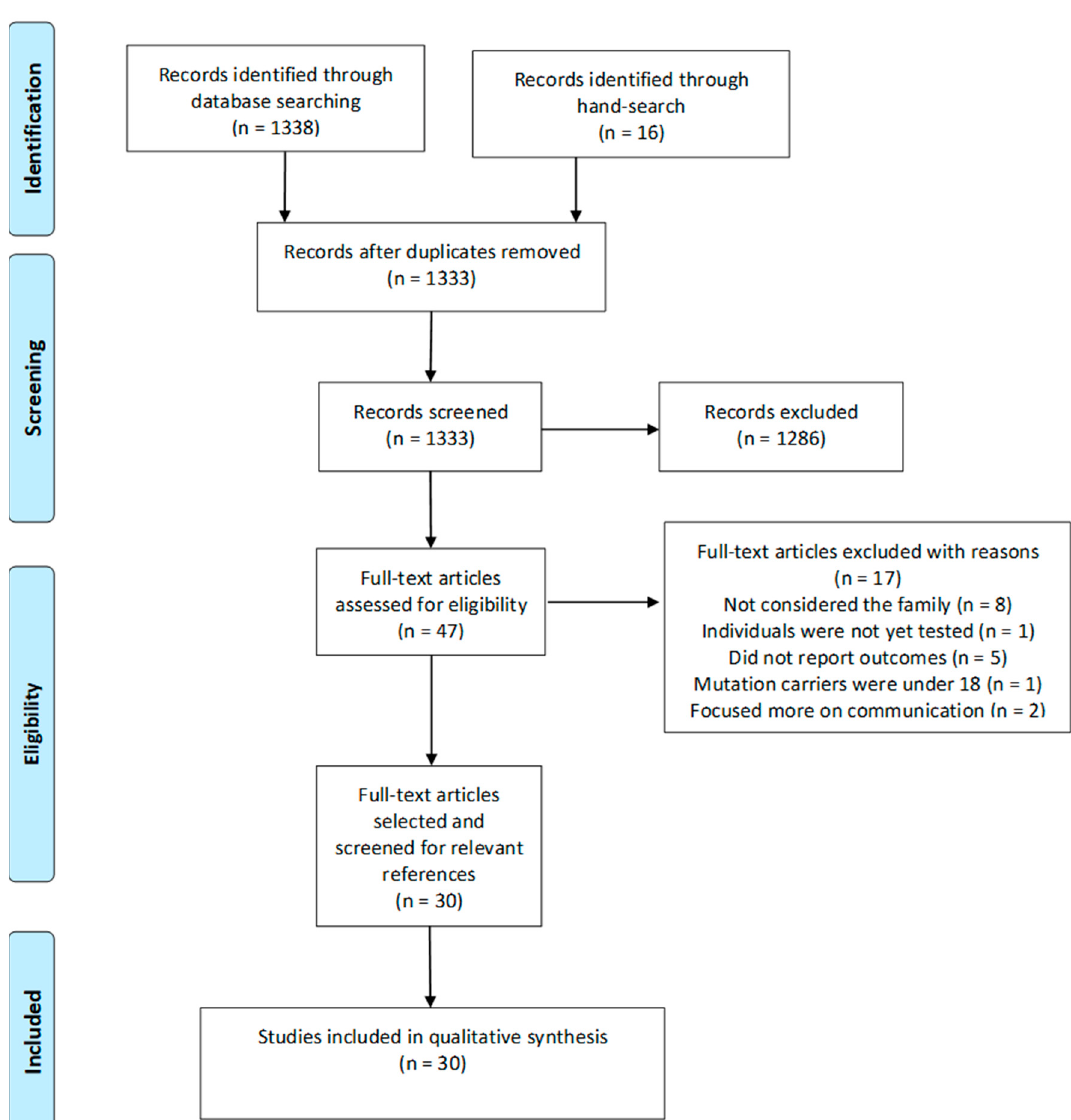
Figure 1. PRISMA